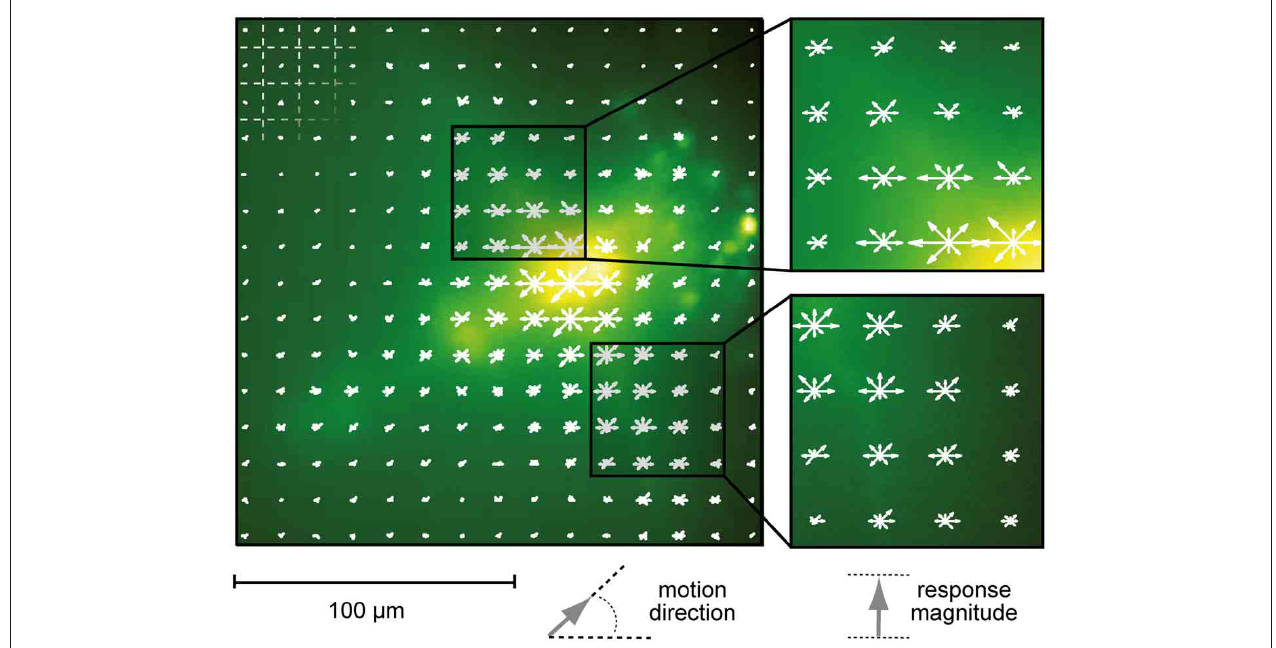
FIGURE 3 | Localization of motion responses. Local changes in Calcium Green fluorescence induced by stimulation with motion in eight directions. The length of each arrow represents average fluorescence increase ( (cid:3) F ) in the underlying square region of the image (indicated by the grid in the